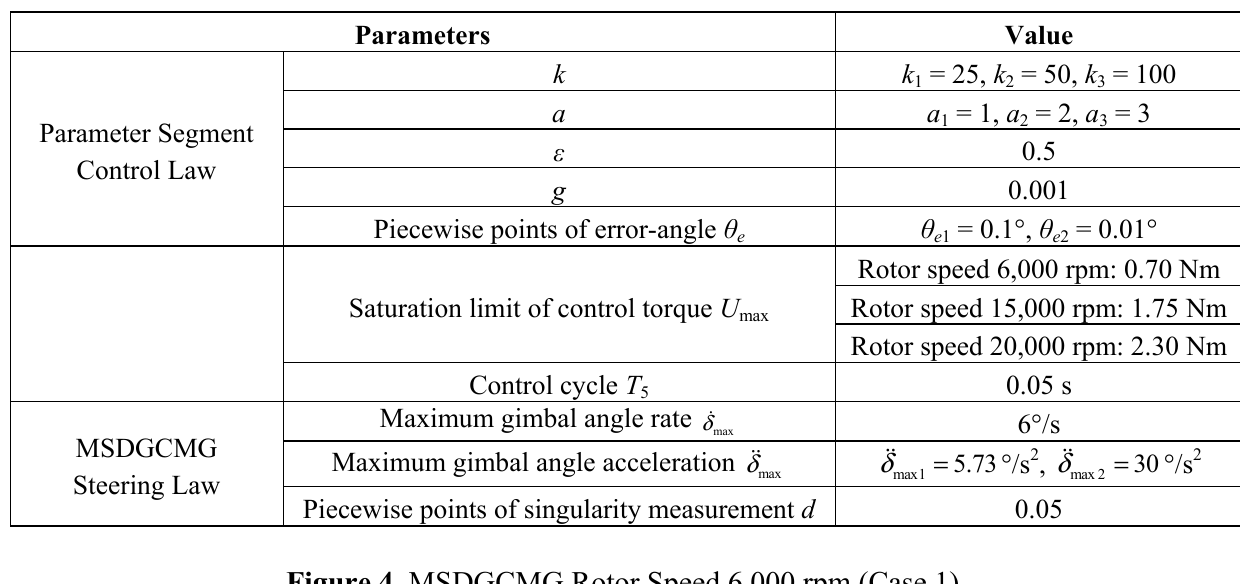
Table 2. Parameters and Values of Experiment.